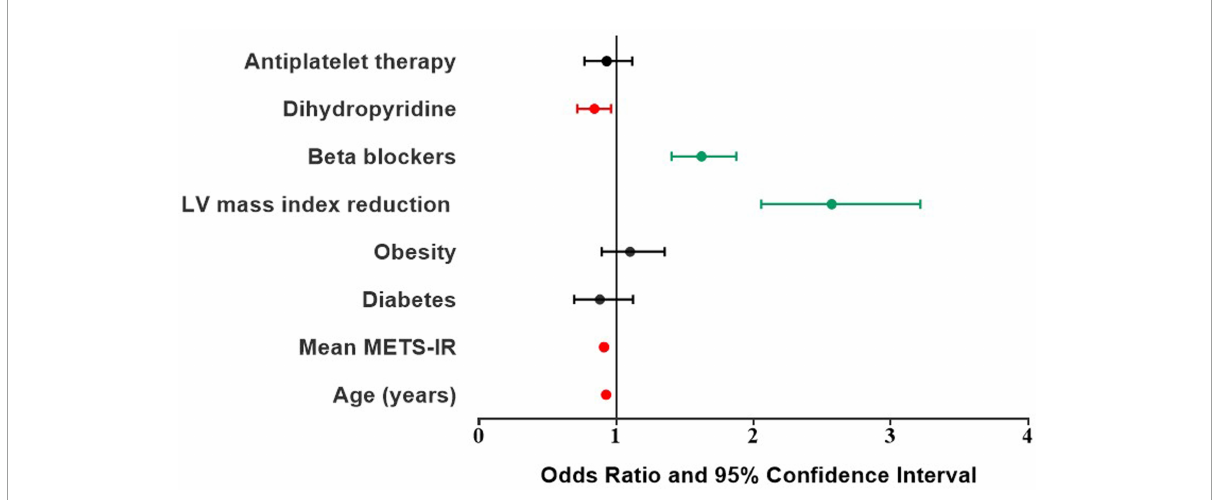
FIGURE2 Odds ratio and 95% confidence interval of clinical and therapeutic determinants of delta MEEi improvement. MEEi, indexed mechano-energetic